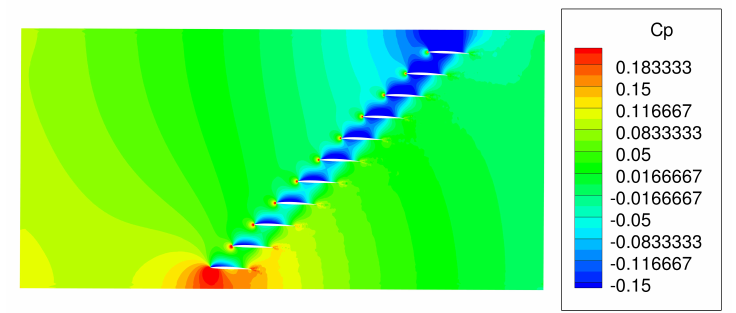
Figure 8. Computed normalised mid-span steady pressure